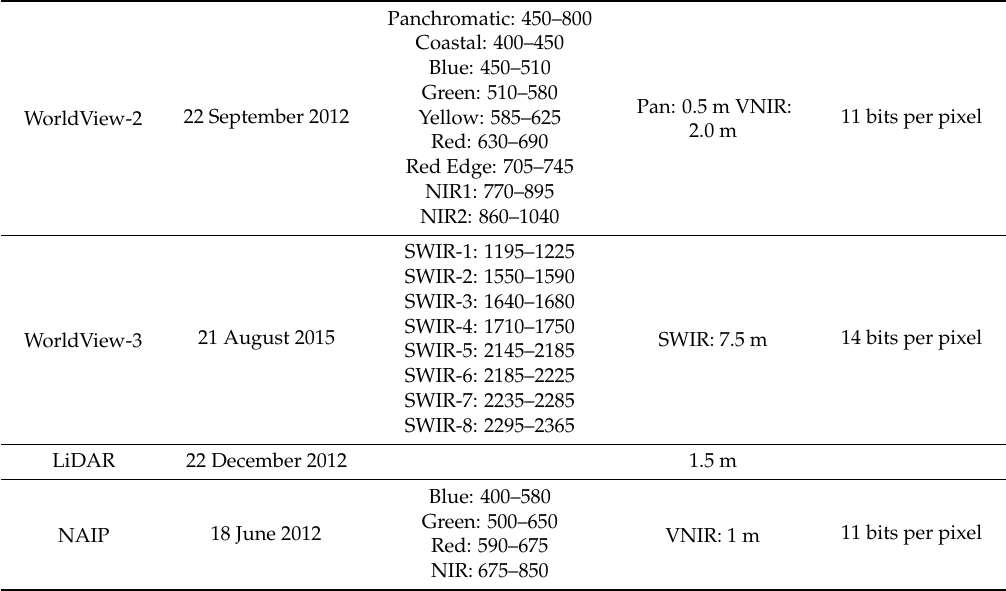
Table 2. Remotely sensed